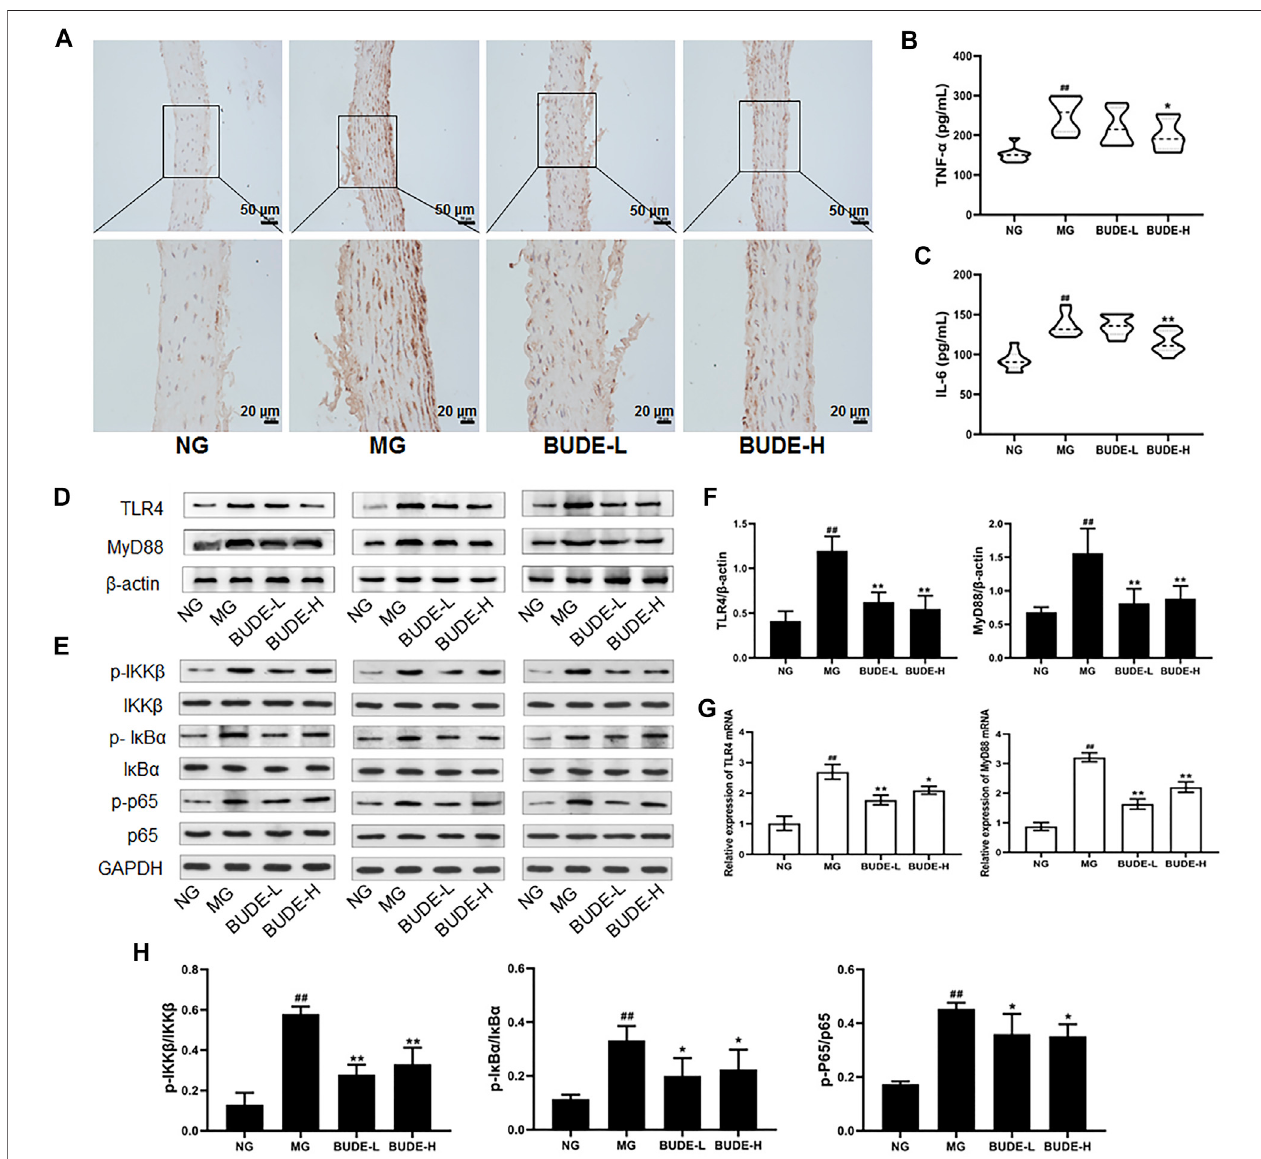
FIGURE 5 | Effect of BUDE on the TLR4/MyD88 pathway in the vessel. (A) Immunohistochemical staining of TLR4 in the vessel (100 × , 200 × ). (B) Changes in the plasma tumor necrosis factor- α (TNF- α ) (C) Changes in the plasma interleukin-6 (IL-6). (D-F, H) Western blot assaying on the levels of TLR4, MyD88, IKK β and phosphorylation, IKB α and phosphorylation, p65 and phosphorylation in the vessel (G) Relative expressions of TLR4 and MyD88 mRNA. Compared with the normal control group # p < 0.05, ## p < 0.01; compared with the model control group * p < 0.05, ** p < 0.01, n (cid:2) 3, 9.